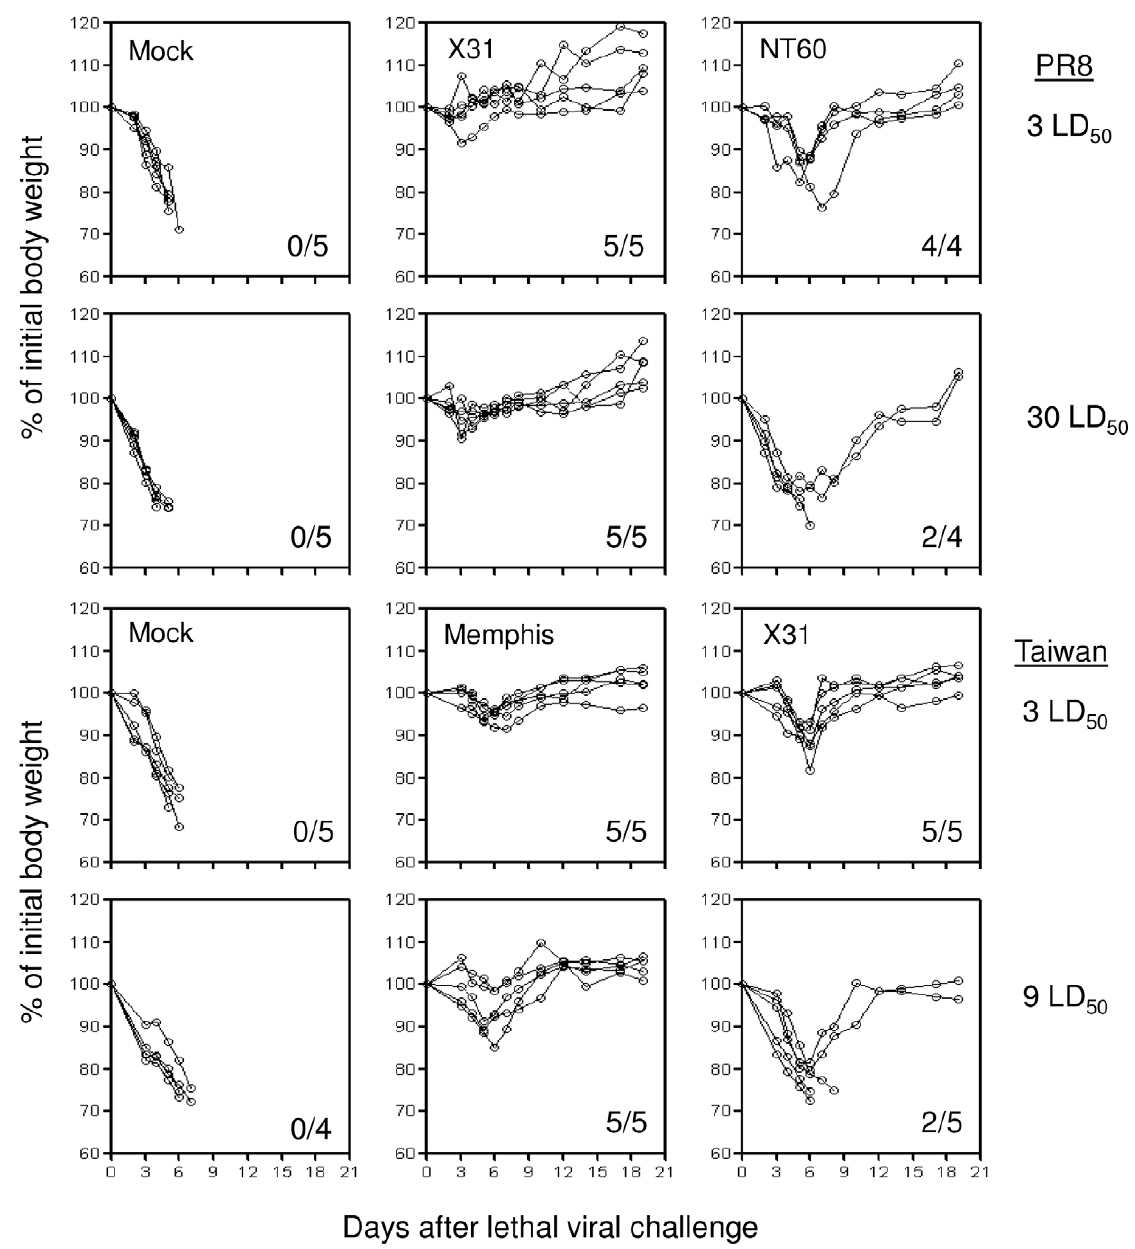
Figure 1. Body weight loss and survival after heterosubtypic influenza virus infections. Five to eight B6 mice per group were primed intranasally with X31 or Memphis H3N2 influenza A viruses as indicated or equal volume of allantoic fluid as control. 35 to 45 days after priming, the animals were challenged with lethal doses of heterosubtypic H1N1 influenza viruses as indicated. Body weight loss (left panel) and survival (right panel) of the animals were monitored until day 19 after lethal challenge. Animals that lost 25% of their initial body weight were considered moribund and sacrificed according the animal protocol. The results were expressed as body weight loss of individual mice per group. The numbers on the lower right corner of each graph indicate survival rate of each group (the number of animals survived/total number of animals tested).